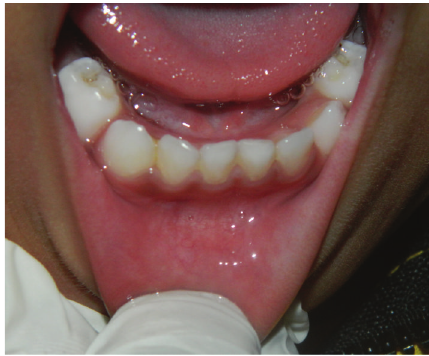
Figure 5: Appearance of the surgical area 12 months after the inter- vention, no